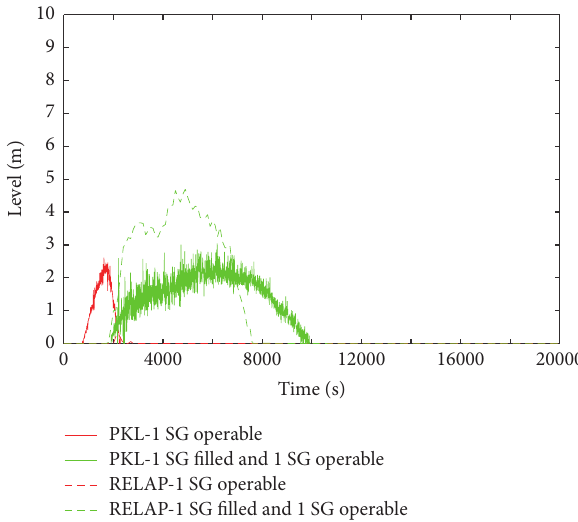
Figure 14: Inlet SG2 level. PKL versus RELAP5. Steam generators influence. Phase